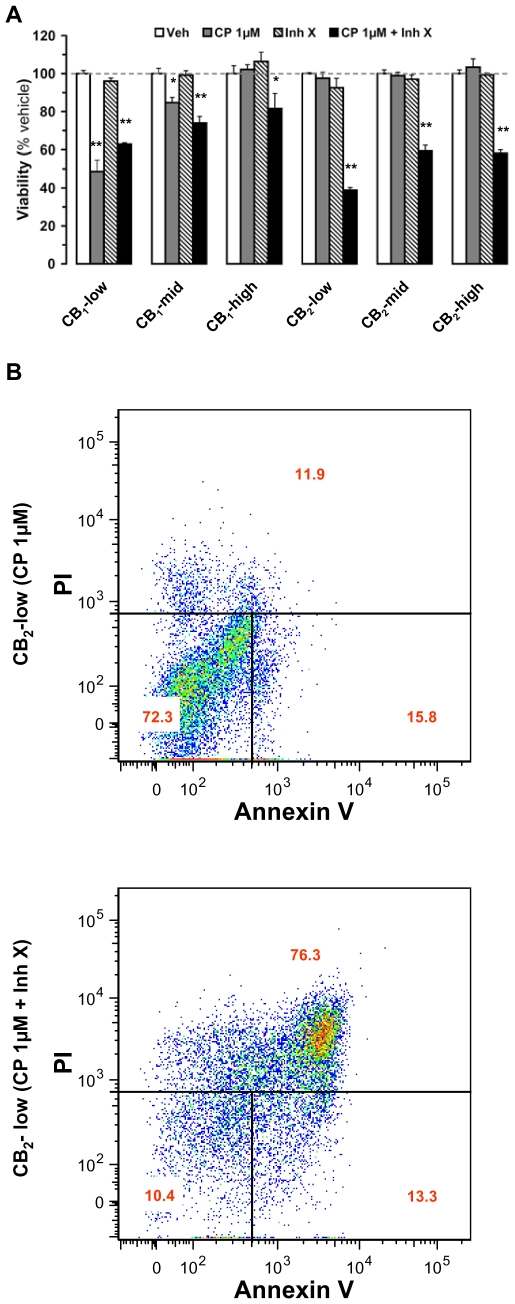
Inhibition of AKT signaling confers sensitivity of cannabinoid receptor-expressing DBT cells to cannabinoid-dependent cytotoxicity.
(a) Wild-type (wt) DBT cells and DBT subclones stably expressing cannabinoid receptors were expanded in 24-well plates, incubated with CP-55,940 (CP) at 1 µM (receptor-mediated) without or with Inhibitor X (5 µM added 10 min before CP), and cell viability was assessed after 5 days by quantifying WST-1 conversion. Data represent means±s.e.m. of 3–9 independent experiments in triplicate. (*) = p<0.05 and (**) = p<0.01 significantly different from the viability in the presence of vehicle only, ANOVA followed by Bonferroni's post-test. (b) wt and CB2-low DBT cells were expanded in 6-well plates, incubated with CP at 1 µM (receptor-mediated) without or with Inhibitor X (5 µM added 10 min before CP), and the apoptotic response assessed after 5 days by propidium iodine (PI) and annexin V staining by FACS after 1, 3, and 5 days. Shown are representative results, with values within each quadrant = mean of 3–5 independent experiments.